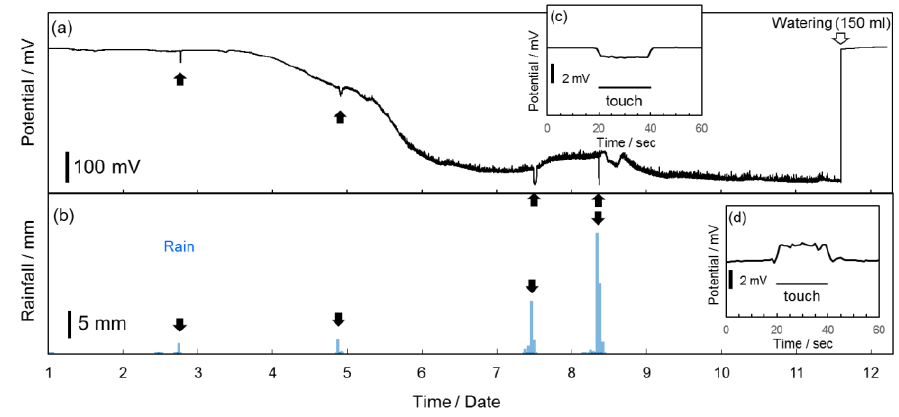
Figure 4. ( a ) Potential changes between a pair of BDD plate electrodes on Aloe during watering and rains over 11 days (from 2 to 13 October 2016). ( b ) Rainfall over the same 11 days. ( c ) Response to a finger touch stimulus when the plants were relatively water-starved. ( d ) Response after 150 mL watering.